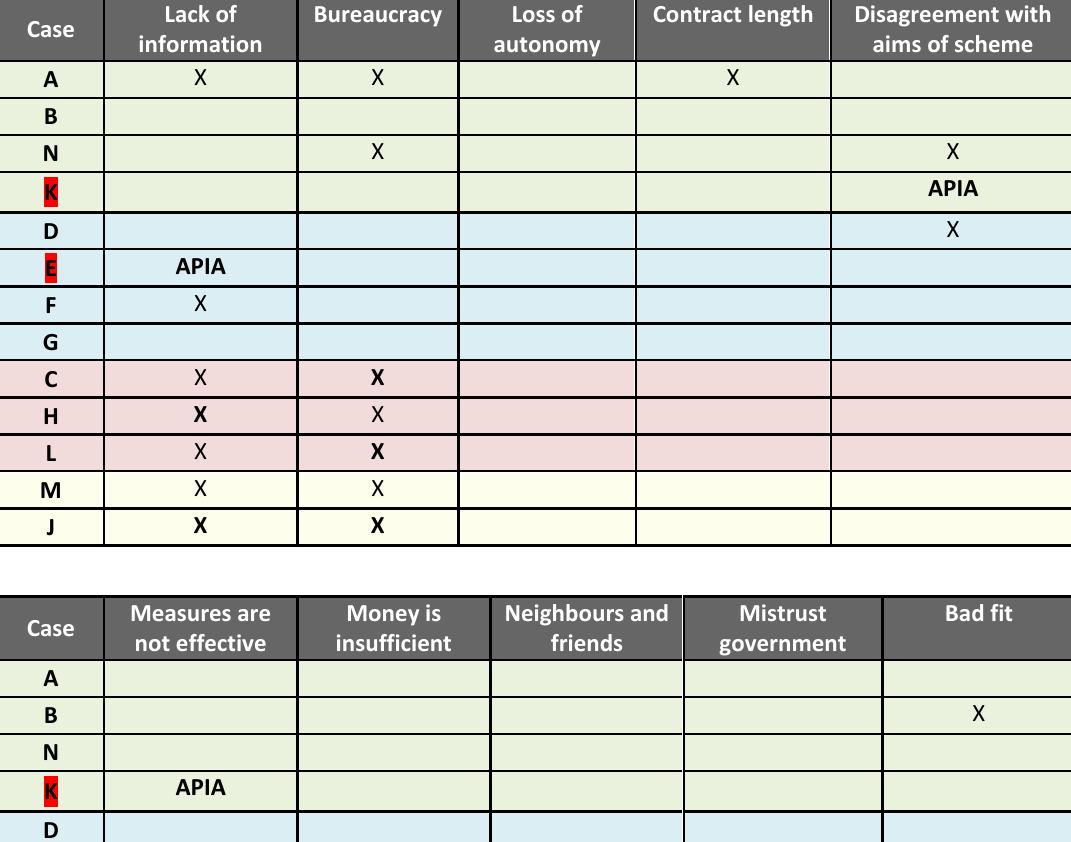
Table 4: Manifestations of Impediments to Participation Green: participants (group 1); blue: participants (group 2); red: drop-outs (groups 3 and 4); yellow: non-participants; highlighted red: APIA drop-outs who switched to ADEPT Bold: main considerations; APIA: for APIA program only; () = not stated